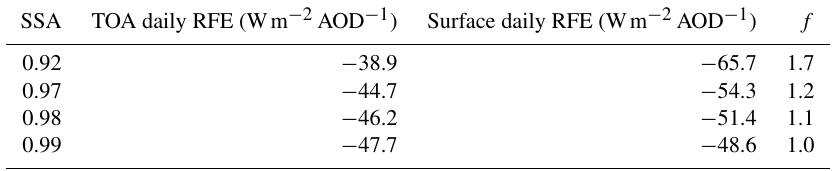
Table 2. Top of the atmosphere (TOA) and surface daily radiative forcing efficiency (RFE), as well as the ratio f = surface daily RFE/TOA daily RFE, as a function of the single scattering albedo